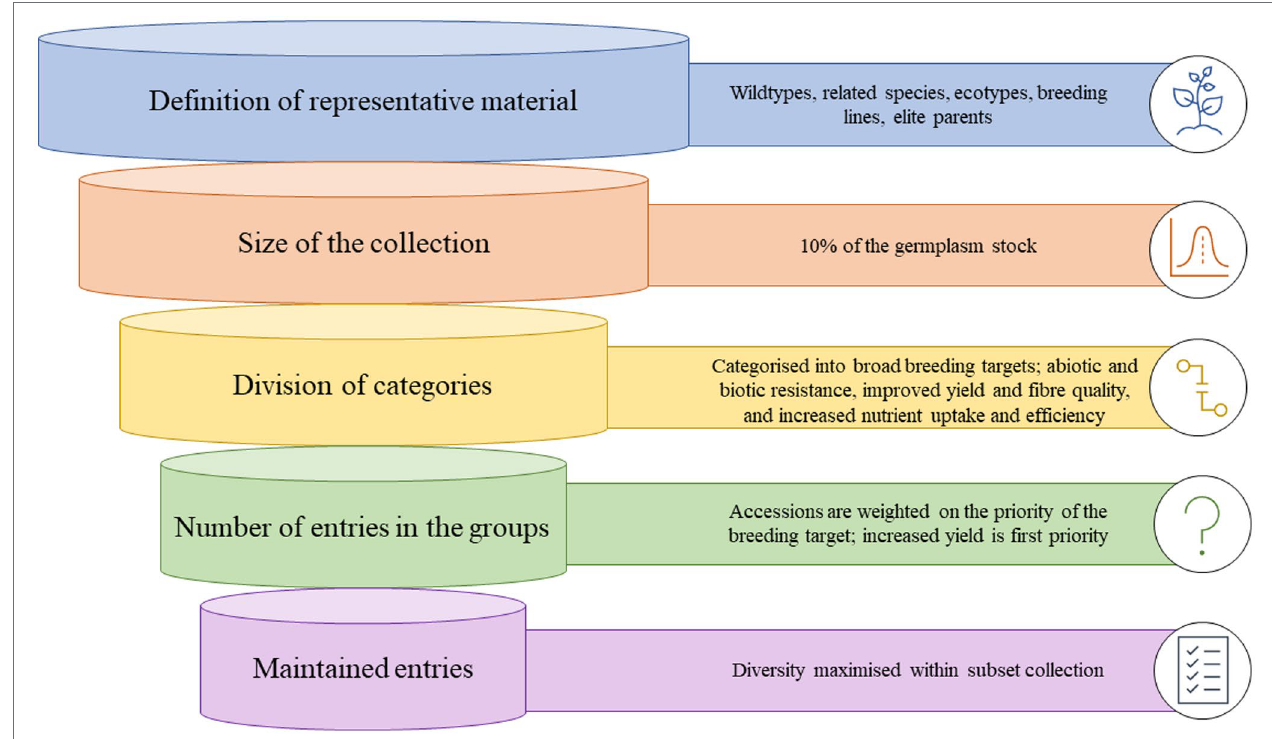
FIGURE 1 | Graphic representation of how a core collection of cotton germplasm could be developed from entire germplasm